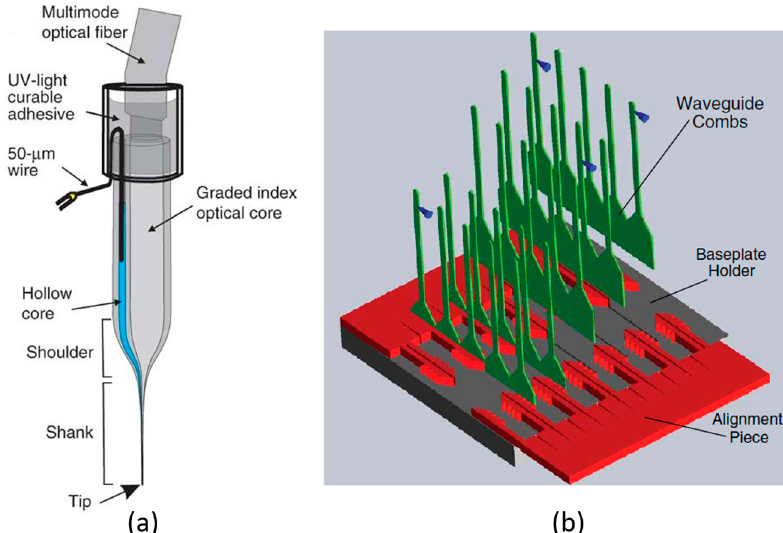
Figure 1. ( a ) Schematic diagram of the multimode optical fibre-coupled probe in [31]. A graded index optical core is coupled with the optical fibre to realise light delivery. A hollow core is used for the in situ observation of neural activities. The shaft tip is shaped to 10 µm diameter for single-neuron manipulation. This figure is reprinted with permission from ref. [31]. ( b ) Picture of the 3D waveguide optical array in [33]. This figure is reprinted with permission from ref. [33].